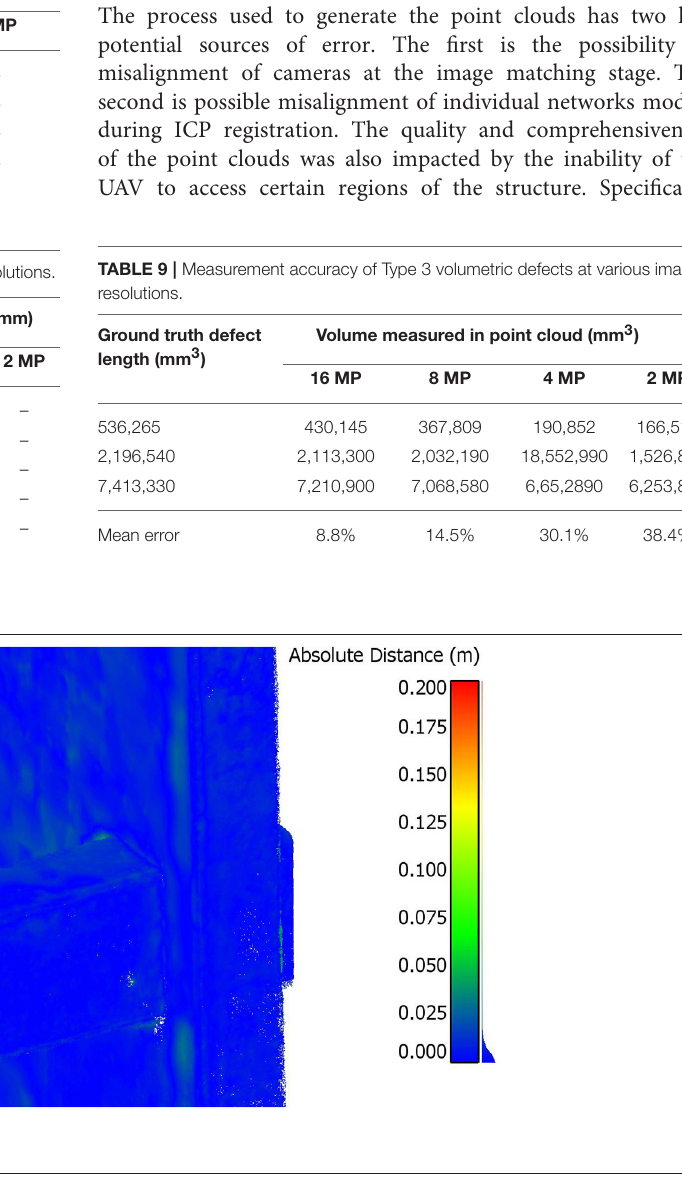
TABLE 7 | Measurement accuracy of 3 mm width type 1 defects at various image resolutions. Ground truth defect length (mm)